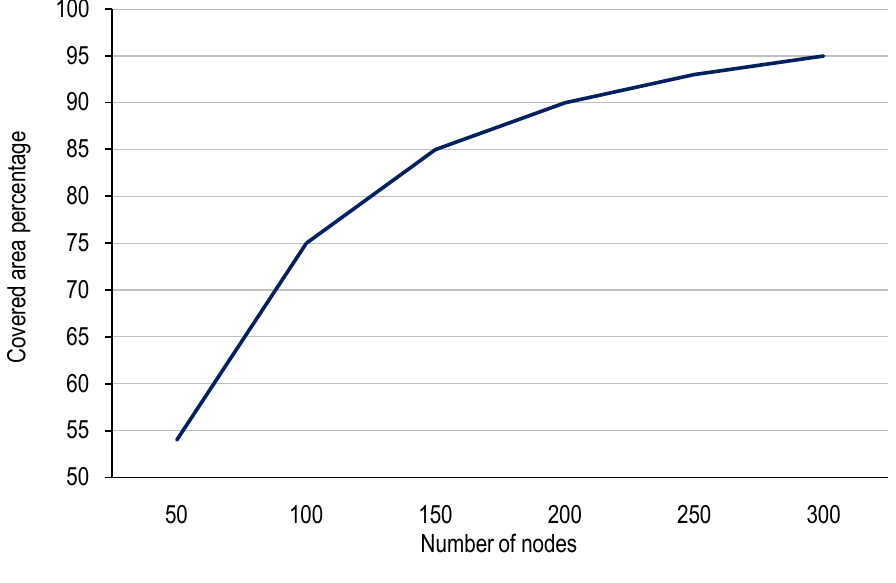
Figure 8. Percentage of the covered area with respect to the whole deployment